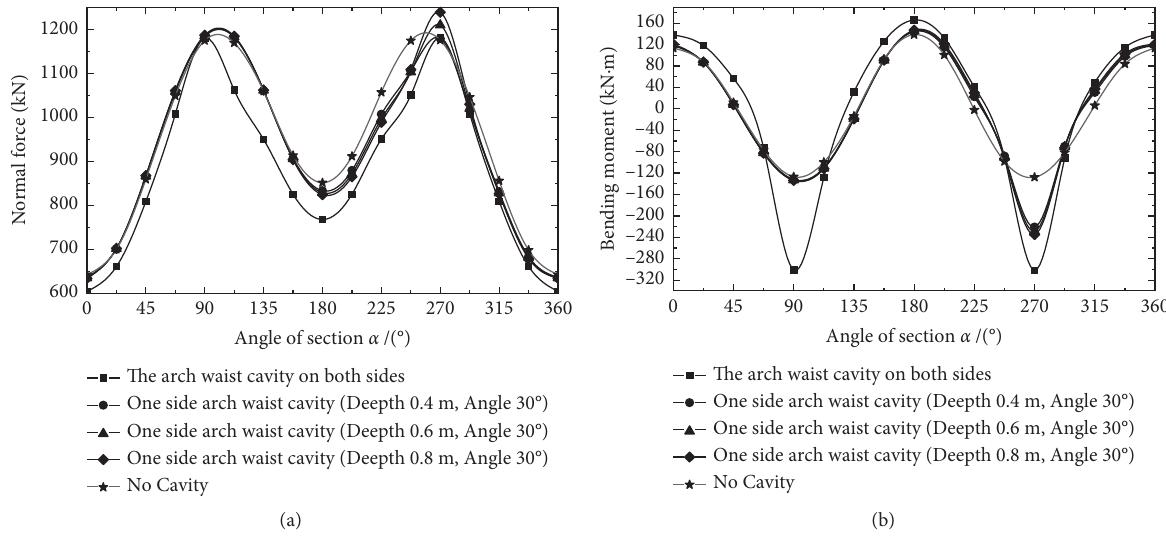
Figure 22: Internal force diagram of the cavity behind the arch waist on both sides. (a) Segment axial force. (b) Segment bending